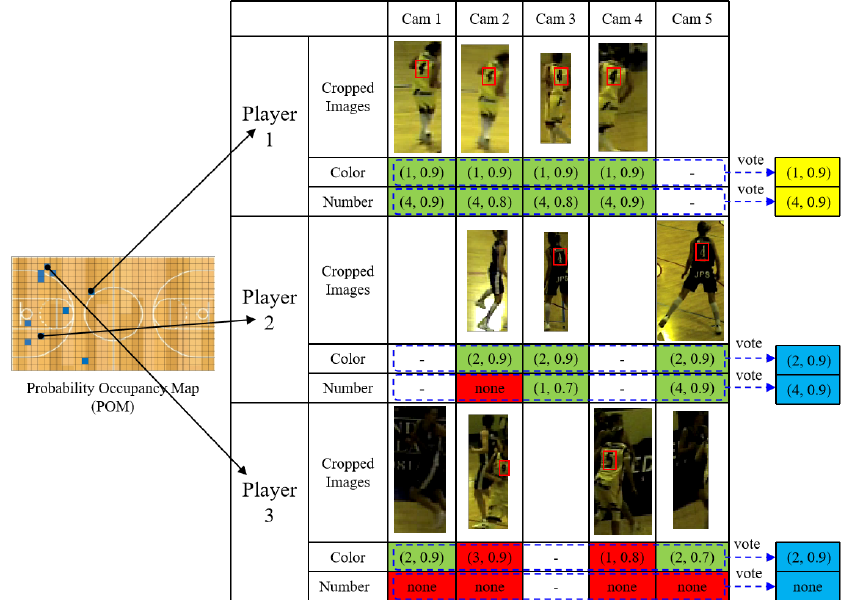
Figure 5. The illustration of feature extraction and fusion: players 1, 2 and 3 are taken as three examples that correspond three locations in the probability occupancy map, respectively. For each player, it can be mapped into several views to crop its image patches. The jersey color and jersey number can be jointly determined by all the cropped images, which can be done by Boyer–Moore voting algorithm. The output of color feature can be represented as ( L c , p ) where L c ∈ {1 (yellow), 2 (blue), 3 (yellow and blue), 4 (none)} and p means its probability. The output of number feature can be denoted as ( L n , q ) where L n and q is the jersey number and its probability,